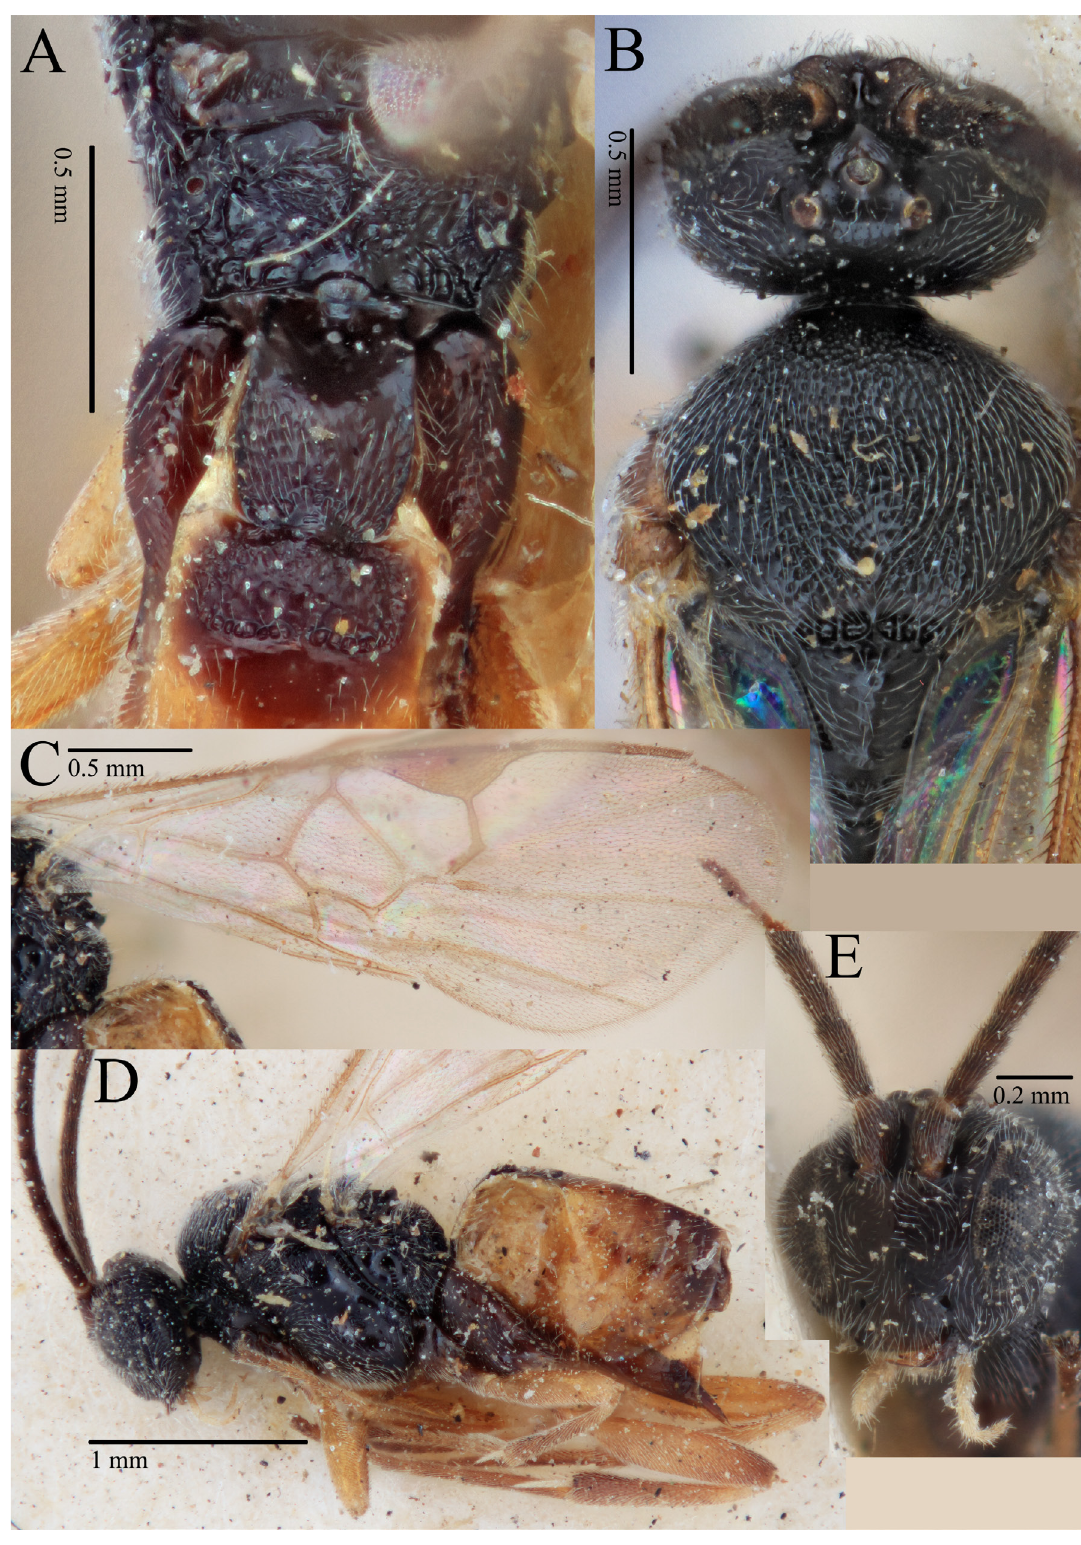
Fig. 13. Cotesia anthelae (Wilkinson, 1928). A . Paratype (NHMUK 3.c.002). B–E . Holotype (NHMUK 3.c.002). A . Propodeum and T1–2. B . Anteromesoscutum. C . Fore wing. D . Habitus in lateral view. E . Head in